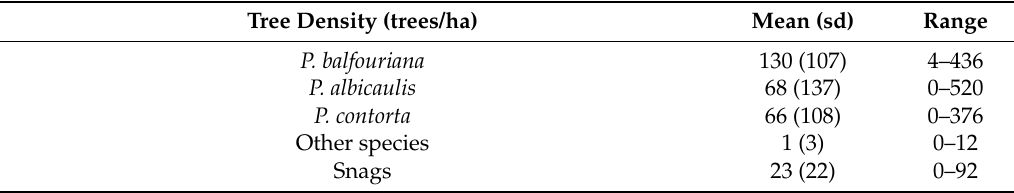
Table 5. Summary statistics of foxtail pine plots measured at Sequoia and Kings Canyon National pine beetle, sd = standard